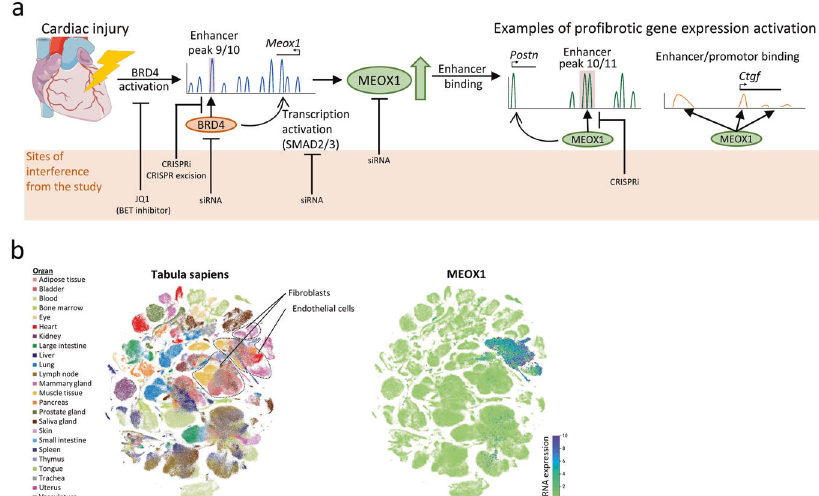
Fig. 1 a Schematic step-by-step overview of the mechanisms leading from cardiac injury to activation of pro- fi brotic gene expression in fi broblasts, as depicted by Alexanian et al. Sites of experimental interference used to clarify critical regulatory elements are highlighted. (heart graphic source: smart.servier.com) b Single-cell RNA expression of MEOX1, including 24 different organs of origin. The fi gure was generated using the single-cell dataset from the tabula sapiens consortium